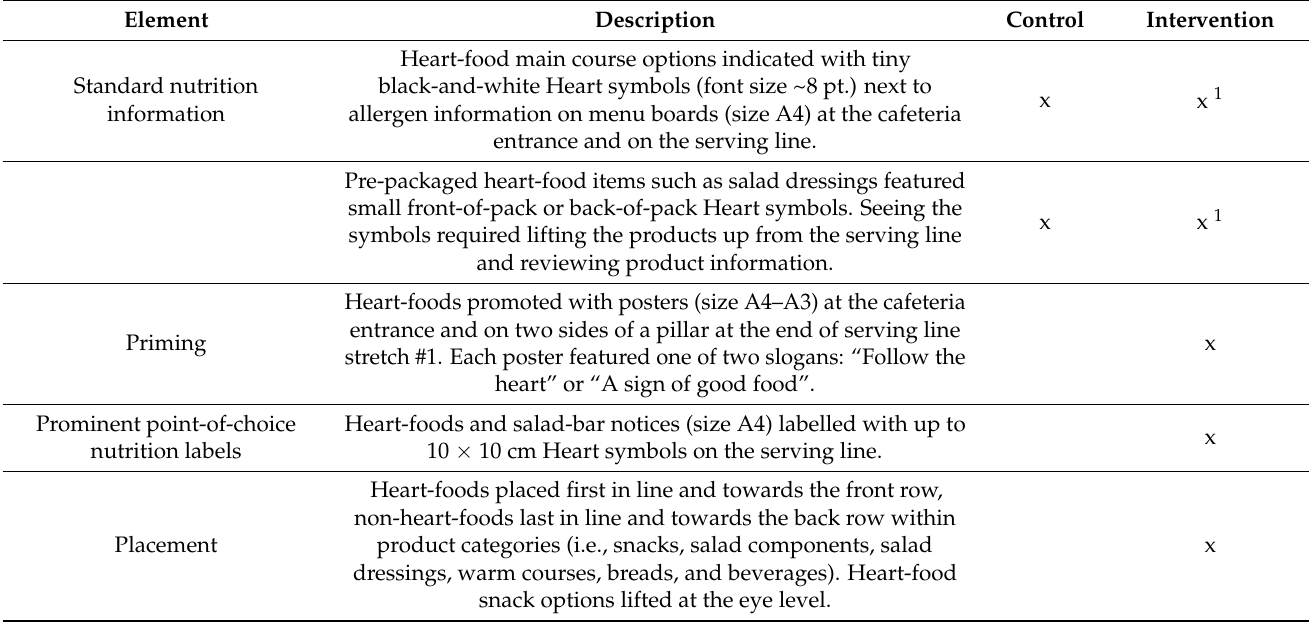
Table 2. Choice-architectural elements in place (x) during control and intervention. Heart-food refers to food items that met the product category-specific nutrition criteria of the Heart